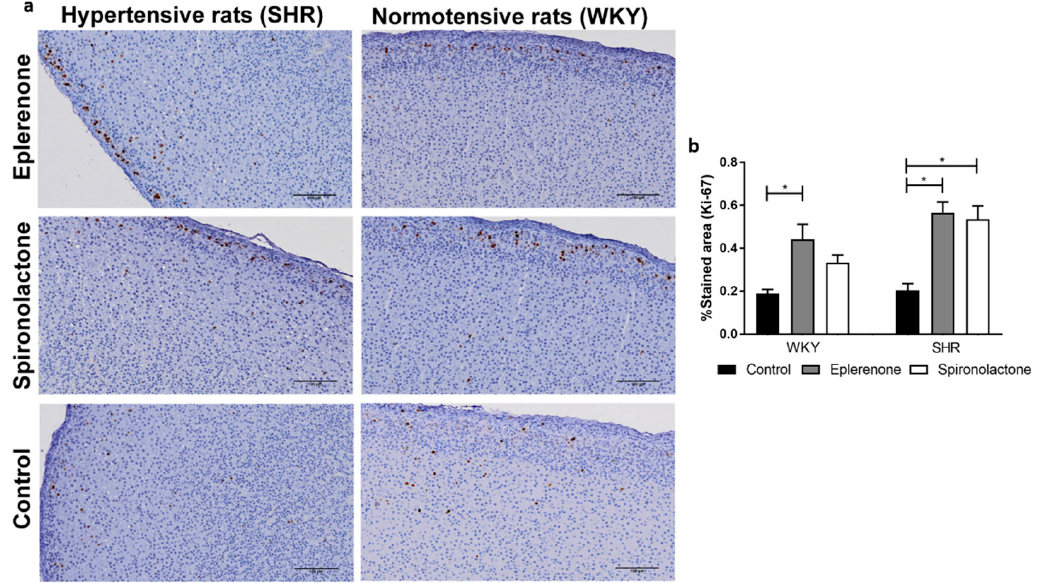
Figure 4. Adrenal glands stained for Ki-67 (100 × ) ( a ) and percentage of stained area for Ki-67 ( b ). * p < 0.05. Proliferation in the cortices of SHR and WKY rats was not significantly different.